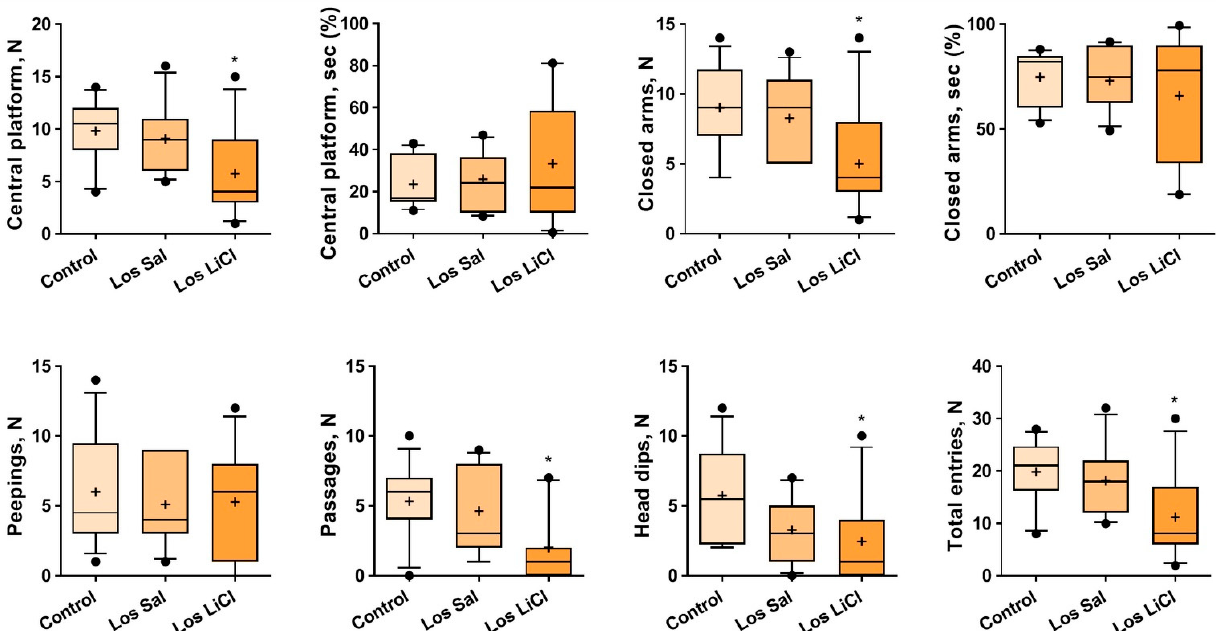
Figure 3 . Effects of chronic LiCl treatment on the behavior of defeated mice in the elevated plus-maze test . Note: Los Sal - Sal-treated losers; and Los LiCl - LiCl-treated losers. * p < 0.05 vs . controls, Tukey’s multiple-comparison post hoc test ( n = 12 for each group). The presented values are means (plus sign), medians (solid lines), and 25%/75% quartiles in the box-whisker plot, with whiskers indicating the 10th and 90th percentiles.